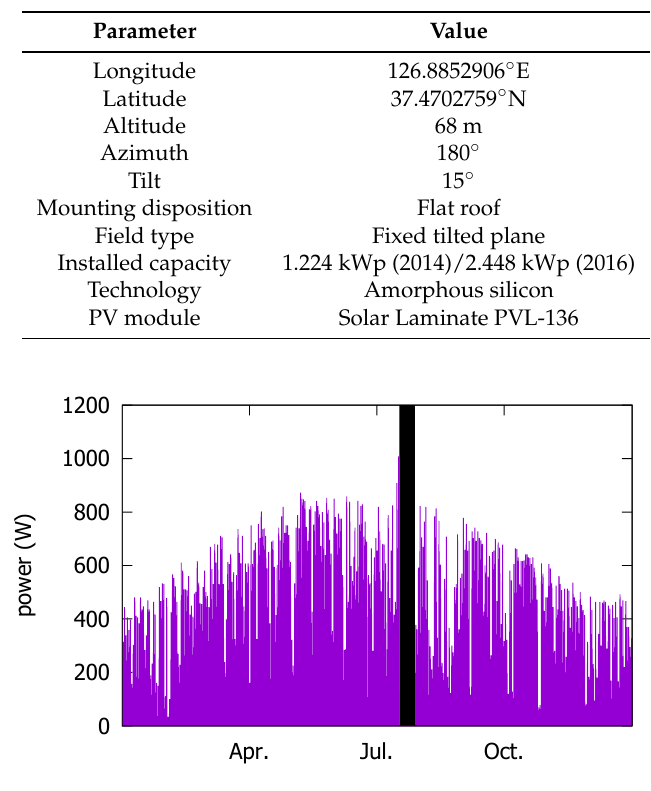
Table 2. Photovoltaic (PV) testbed specification.